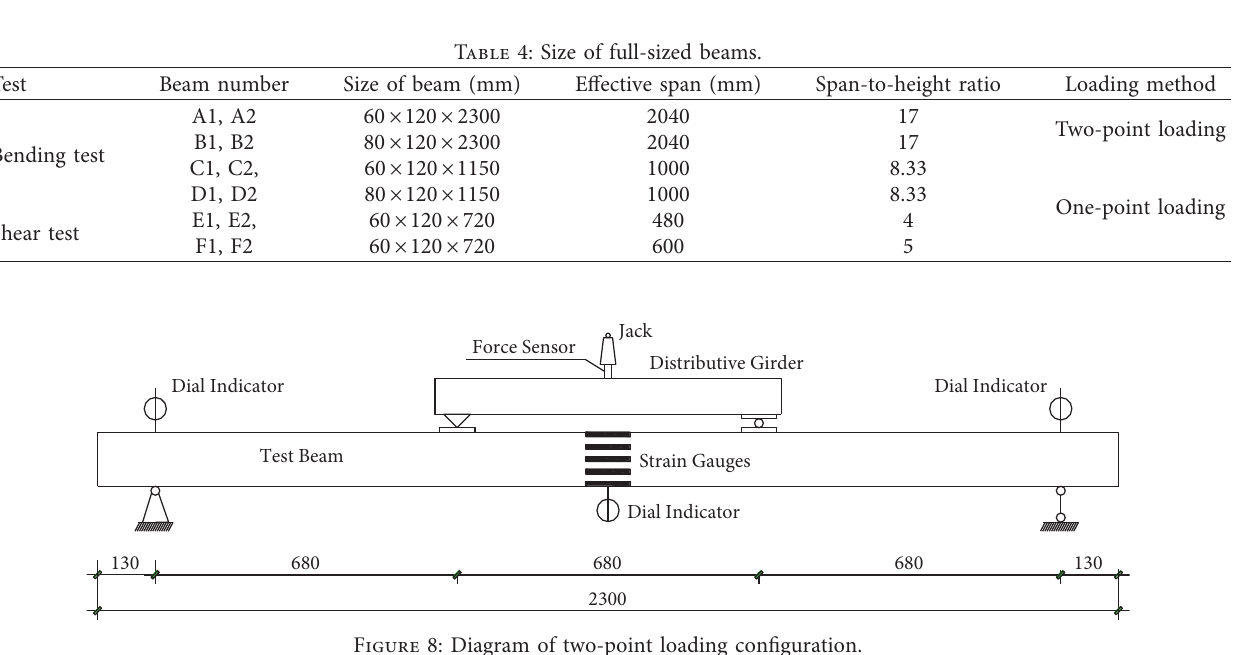
Figure 8: Diagram of two-point loading configuration.